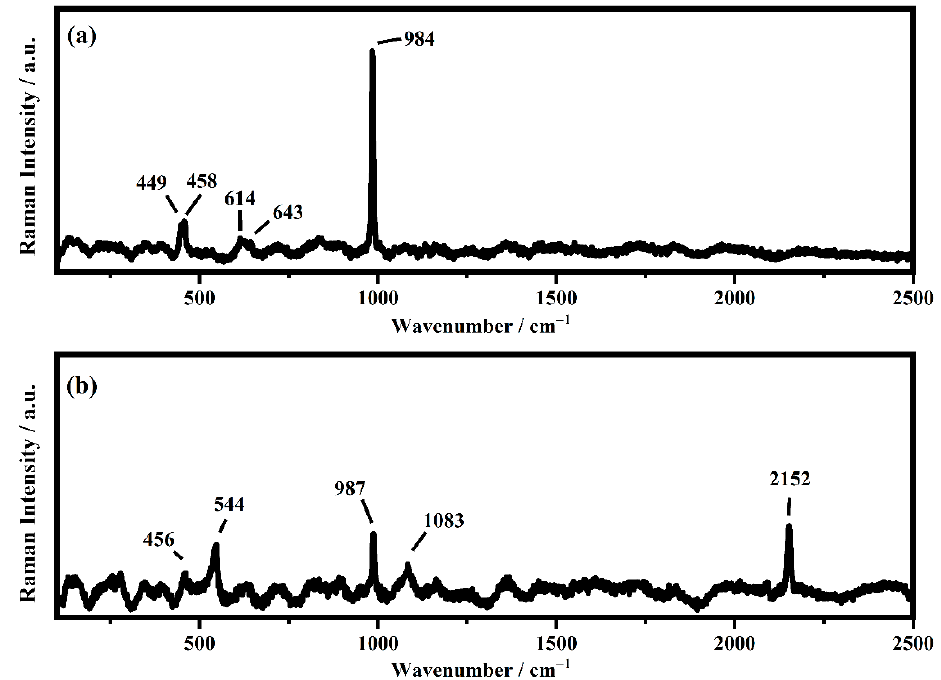
Figure 4. Representative Raman spectra collected on the specimen of Figure 2 with modern pigments such as lithopone ( a ) and Prussian blue ( b ). The Raman spectra shown in this picture were baseline-corrected.